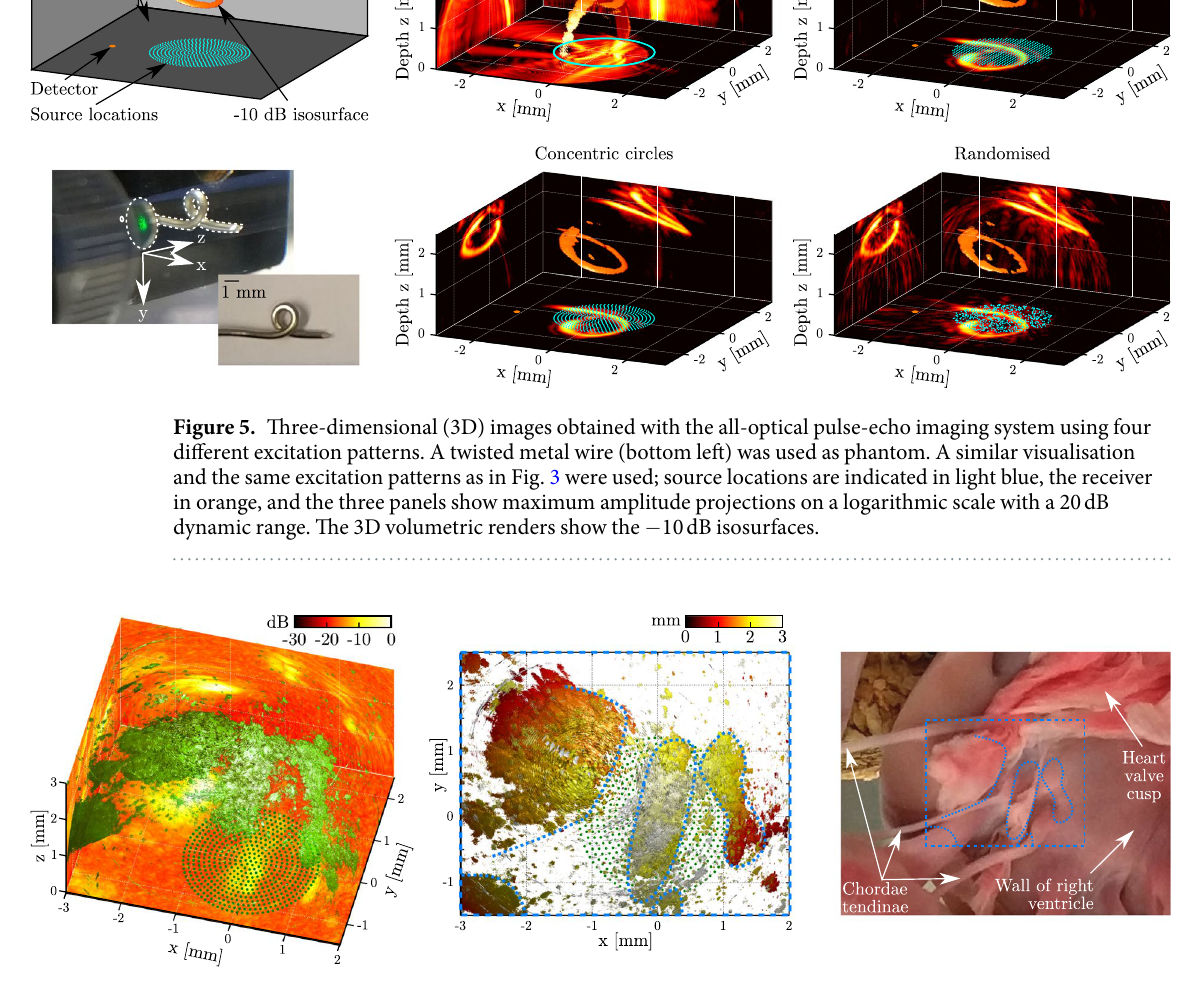
Figure 6. Three-dimensional (3D) image of ex vivo porcine cardiac tissue obtained with the all-optical pulse- echo imaging system. A photograph of the sample, containing myocardium, tendinae chordae (“heart strings”) and a heart valve cusp, is shown on the right. The left panel shows the − 15 dB isosurface (green), and the three planes ( z = 0 mm, x = − 3 mm and y = 2.5 mm) display the maximum intensity projections (logarithmic scale) along the z , y and x directions, respectively. To improve visual depth perception, the middle panel displays the same − 15 dB isosurface with the axial depth indicated in colour. The approximate locations of anatomical features are indicated in blue dotted curves (middle and right), whereas the source locations are indicated by green